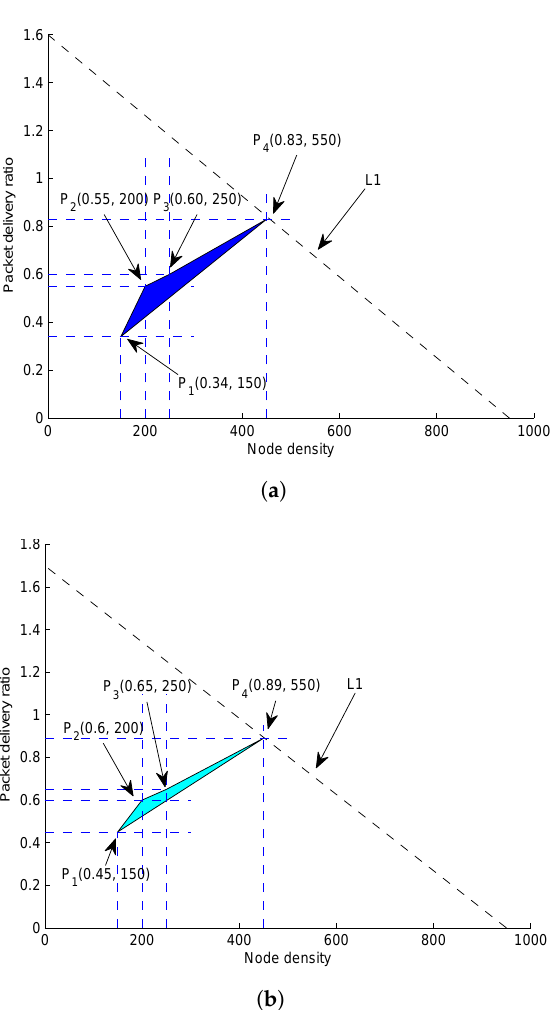
Figure 6. Feasible regions. ( a ) Feasible region for throughput maximization (GDGOR-IA); ( b ) feasible region for throughput maximization